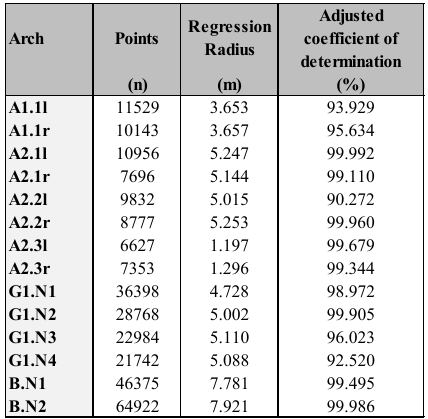
Table 2: Results of the regression circumferences obtained.